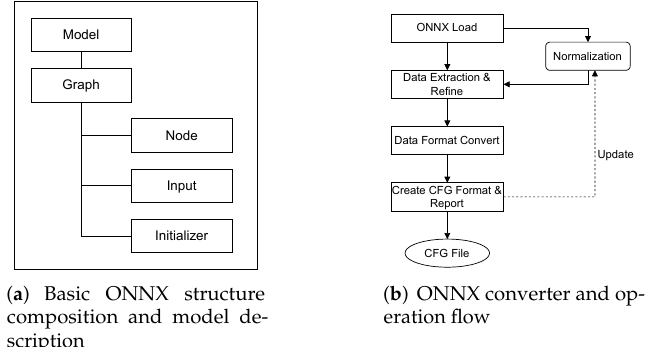
Figure 3. Basic ONNX structure composition and model description, and developed ONNX converter and its operation